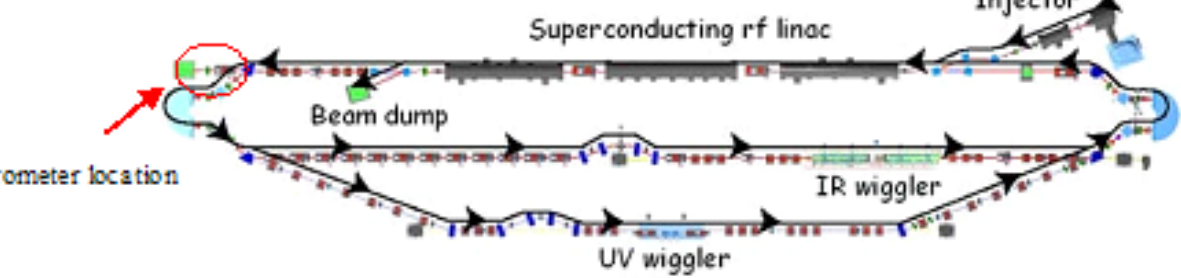
FIG. 1. (Color) Jefferson Lab FEL